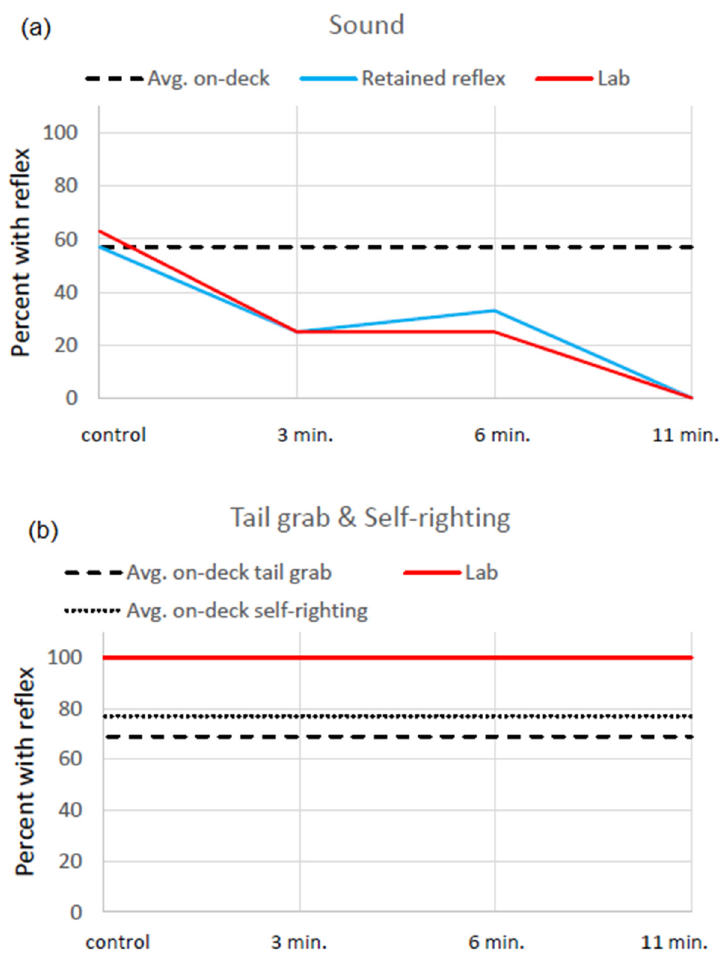
Figure 1. ( a ) Sound; ( b ) Tail grab and Self-righting . The percent of sablefish that successfully per- formed each reflex test, on-deck after capture on hook-and-line longline gear and in the